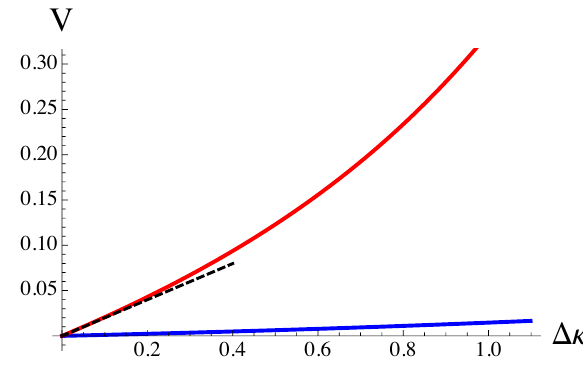
Figure 10 . Relation between ∆ κ and V for α = 2 . 5 flowing funnels. Two thick curves correspond to two branches of the same colors in figure 9. The dashed line is given by the linear approxima- tion